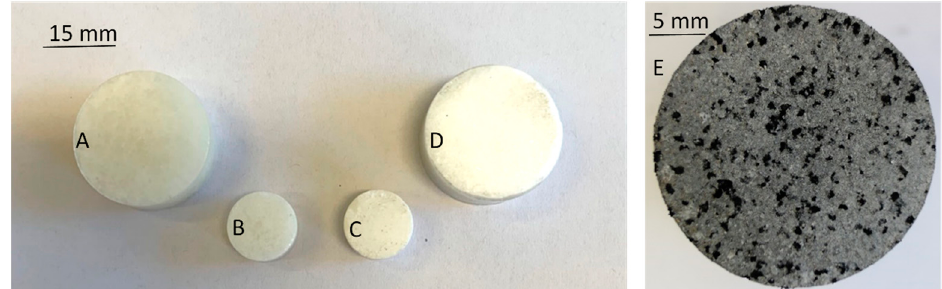
Figure 2. ( A ) A total of 10 g in mass of pure SrBr 2 · 6H 2 O, 25 mm in diameter, 8.5 mm in thickness, and a Figure 2. (A) A total of 10 g in mass of pure SrBr 2 ⋅ 6H 2 O, 25 mm in diameter, 8.5 mm in thickness, and 5.2 kN · mm − 2 compression pressure. ( B ) A total of 0.3 g in mass of pure SrBr 2 · 6H 2 O, 12 mm in diameter, a 5.2 kN ⋅ mm − 2 compression pressure. (B) A total of 0.3 g in mass of pure SrBr 2 ⋅ 6H 2 O, 12 mm in 1.68 mm in thickness, and a 0.77 kN · mm − 2 compression pressure. ( C ) A total of 0.3 g in mass of pure diameter, 1.68 mm in thickness, and a 0.77 kN ⋅ mm − 2 compression pressure. (C) A total of 0.3 g in mass MgSO 4 · 7H 2 O (MSH), 12 mm in diameter, 2.45 mm in thickness, and a 0.77 kN · mm − 2 compression of pure MgSO 4 ⋅ 7H 2 O (MSH), 12 mm in diameter, 2.45 mm in thickness, and a 0.77 kN ⋅ mm − 2 pressure. ( D ) A total of 10 g in mass of pure MgSO 4 · 7H 2 O, 25 mm in diameter, 12.5 mm in thickness, compression pressure. (D) A total of 10 g in mass of pure MgSO 4 ⋅ 7H 2 O, 25 mm in diameter, 12.5 mm and a 5.2 kN · mm − 2 compression pressure. ( E ) MSH / G + C (1:1) composite pellet 10 g in mass, 25 mm in in thickness, and a 5.2 kN ⋅ mm − 2 compression pressure. (E) MSH/G+C (1:1) composite pellet 10 g in diameter, 9.8 mm in thickness, and a 5.2 kN · mm − 2 compression mass, 25 mm in diameter, 9.8 mm in thickness, and a 5.2 kN ⋅ mm − 2 compression pressure.